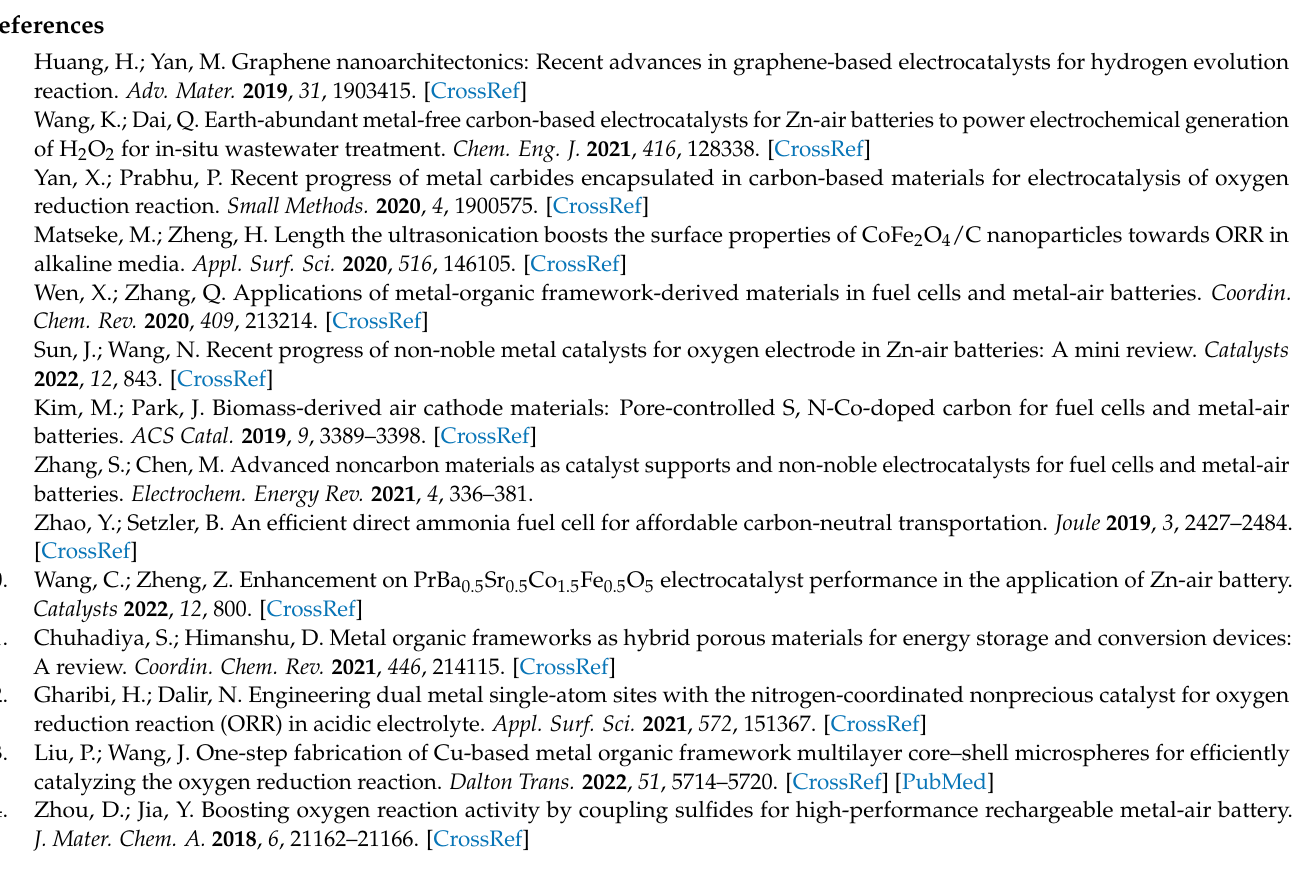
Table S2: The strongest peak properties of Cu/CuO@NC-900 and CuO@NC-900; Table S3: